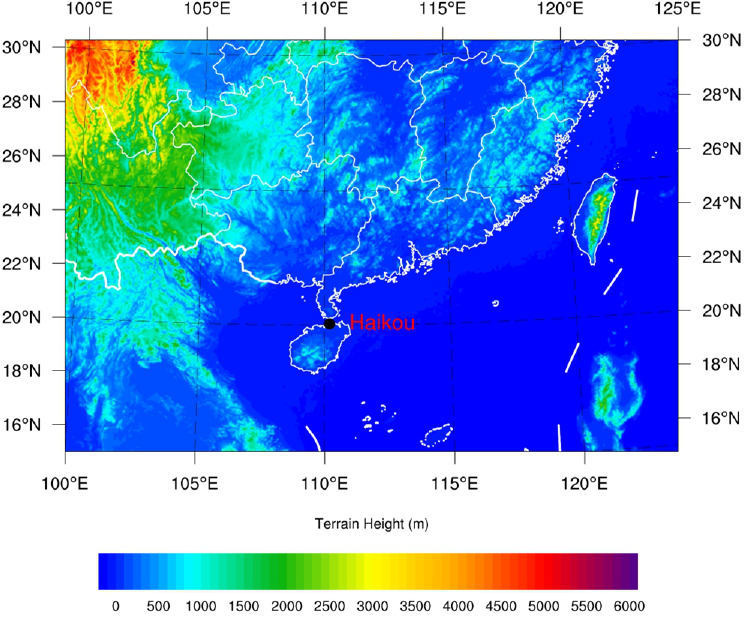
Figure 5. Topographical distribution map of Haikou marine environment site. The black point represents the Haikou radiosonde station.